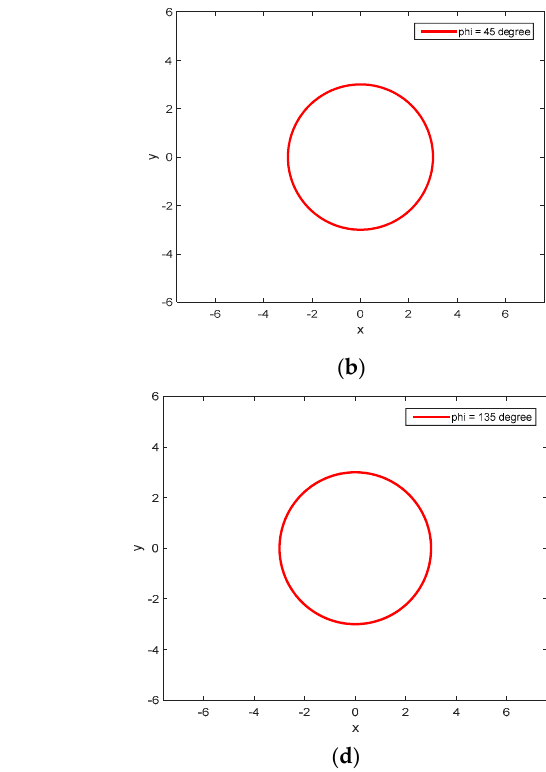
Figure 8. ( a ) Gyroscope display at φ = 0°; ( b ) gyroscope display at φ = 45°; ( c ) gyroscope display at φ = 90°; ( d ) gyroscope display at φ = 135°.